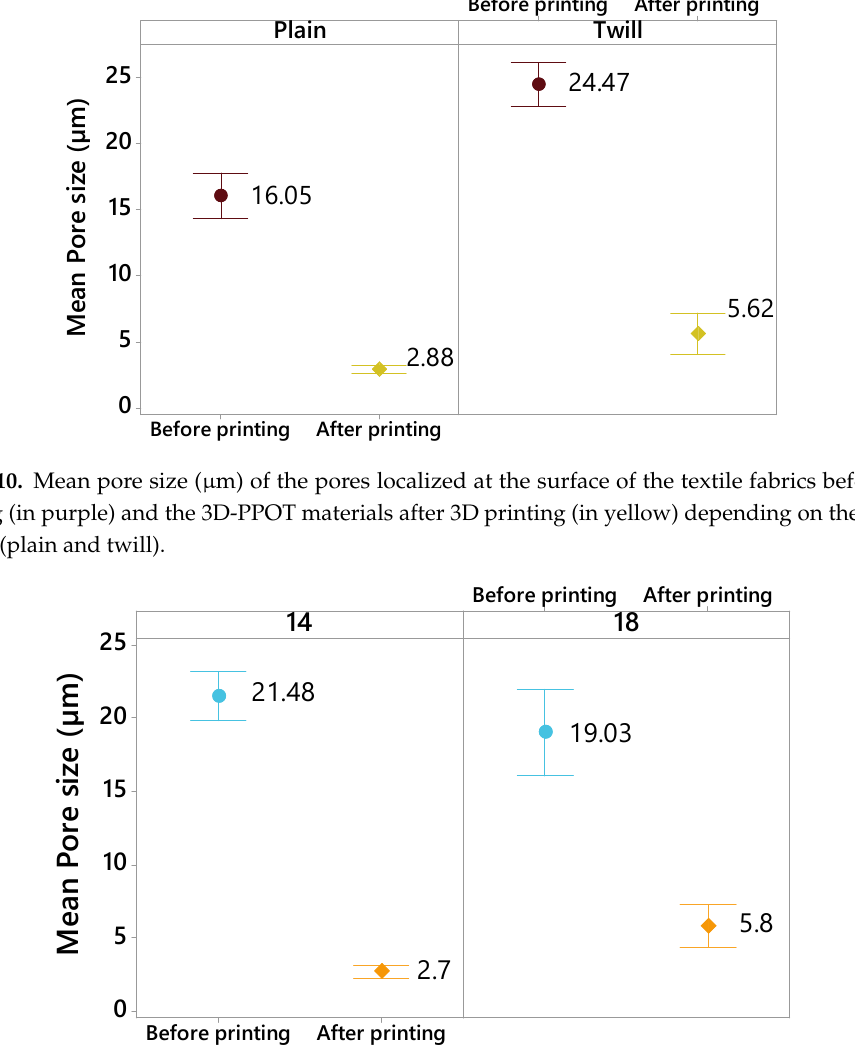
Figure 11. Mean pore size ( µ m) of the pores localized at the surface of the textile fabrics before 3D printing (in blue) and the 3D-PPOT materials after 3D printing (in orange) depending on the weft density of the fabric (14 and 18 pick/inch).